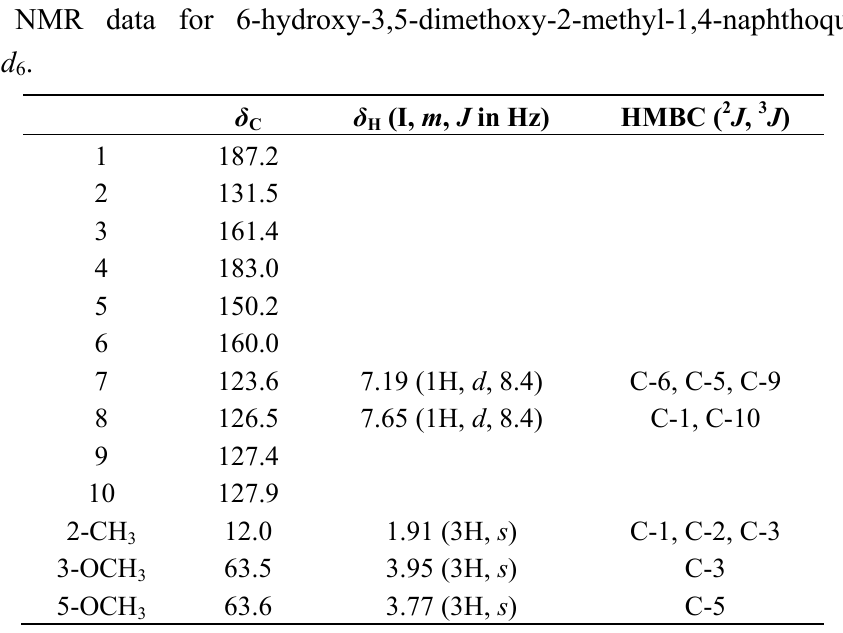
Figure 1. Naphthoquinones isolated from Aloe dawei . For 6-hydroxy-3,5-dimethoxy-2- methyl-1,4-naphthoquinone ( 1 ) R 1 = R 2 = OCH